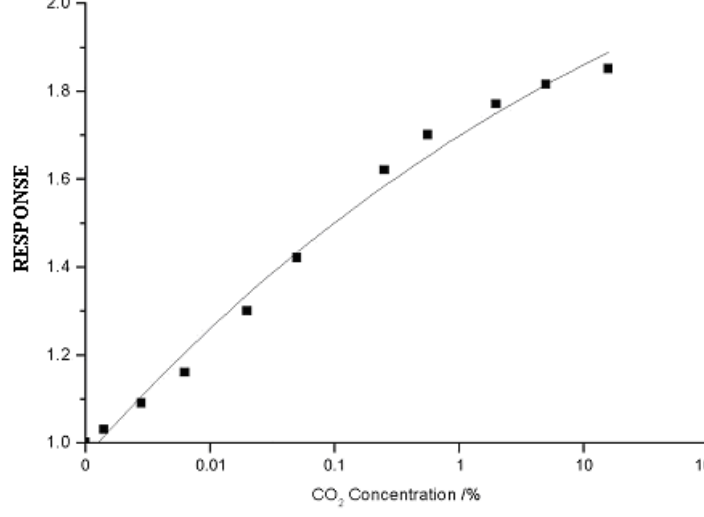
Figure 6. Sensitivity vs. concentration of CO